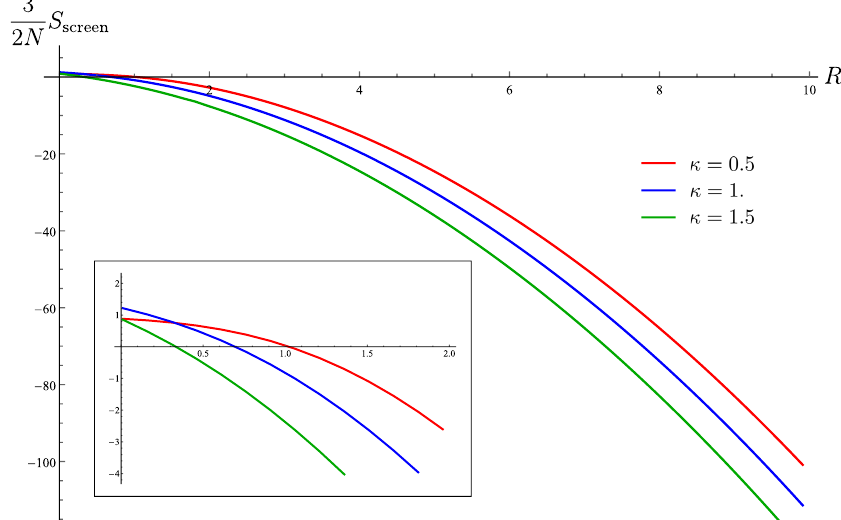
Figure 3 . Our numerical result for the EE of the screened Wilson line, S screen / (2 N/ 3) , as a function of Rv for κ = 0 . 5 (red), 1 (blue), and 1 . 5 (green). The inset shows that S screen / (2 N/ 3) approaches a non-zero value in the limit Rv → 0 , namely the value for the conformal Wilson line in eq.